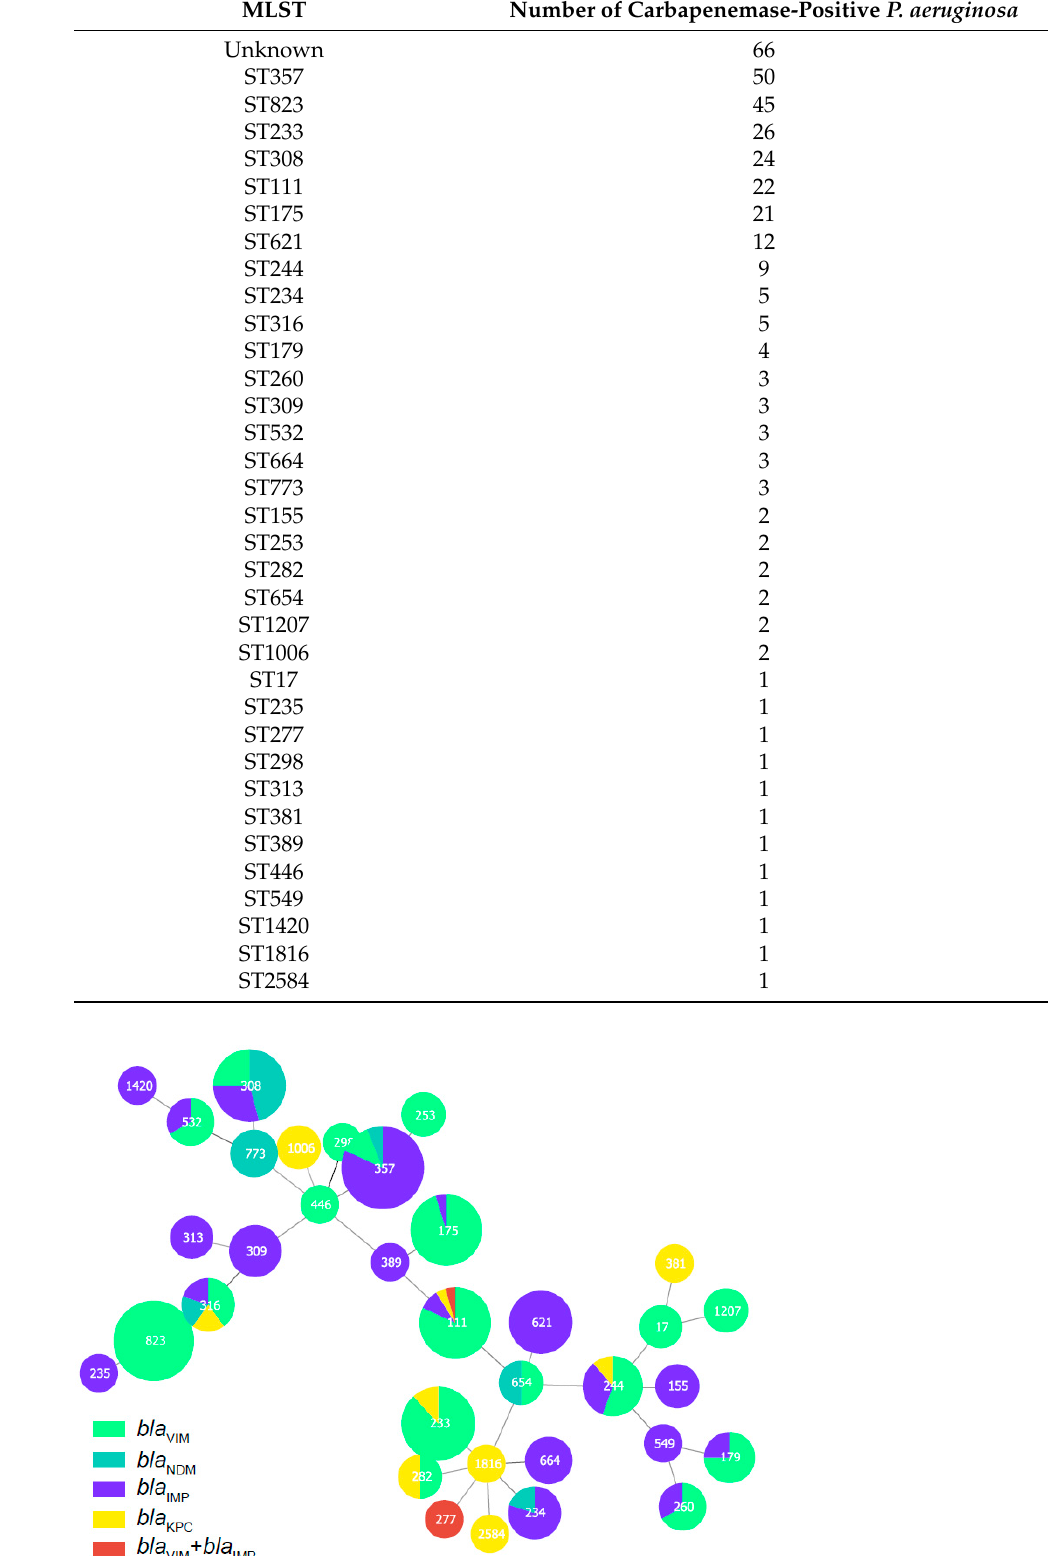
Figure A1. Minimum-spanning tree of carbapenemase-producing P. aeruginosa isolates based on a core-genome MLST (cgMLST). Each node within the tree represents a cgMLST type, with diameters scaled to the number of isolates belonging to that type.